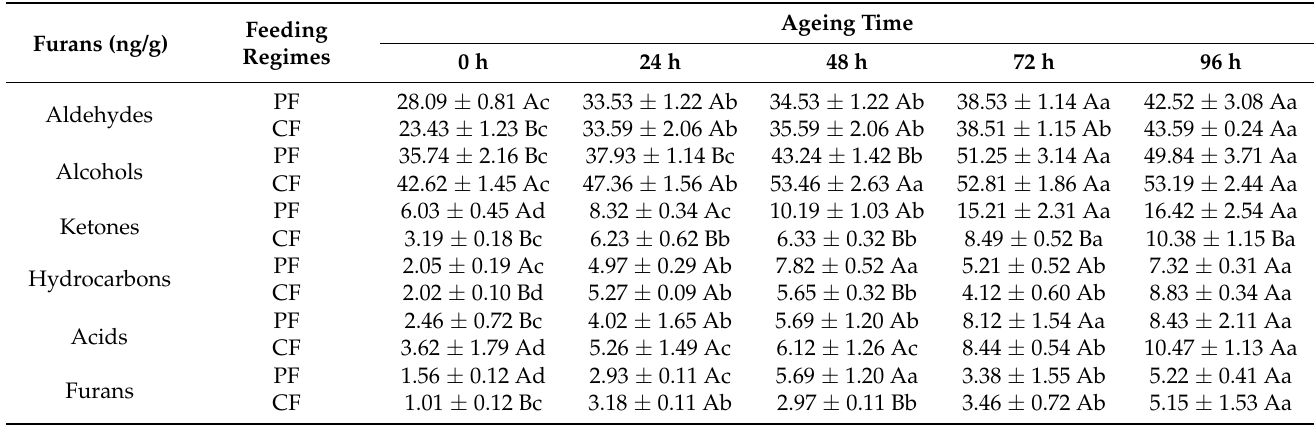
Table 4. Effects of different feeding regimes and postmortem aging times on the concentration of volatile compounds derived from lipid oxidation in the LT muscles of